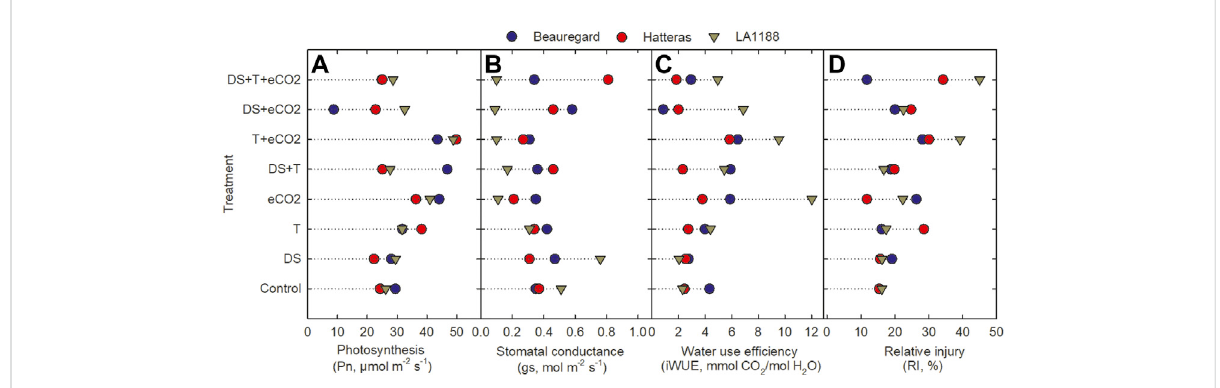
FIGURE 1 Effects of temperature (T), carbon dioxide concentration ([CO 2 ]), drought (DS), and their interaction on (A) photosynthesis rate, (B) stomatal conductance, (C) water use ef fi ciency and (D) relative injury of the cell membrane (RI) of three sweetpotato cultivars (Beauregard, Hatteras, and LA 1188). Each data point indicates the mean ± standard